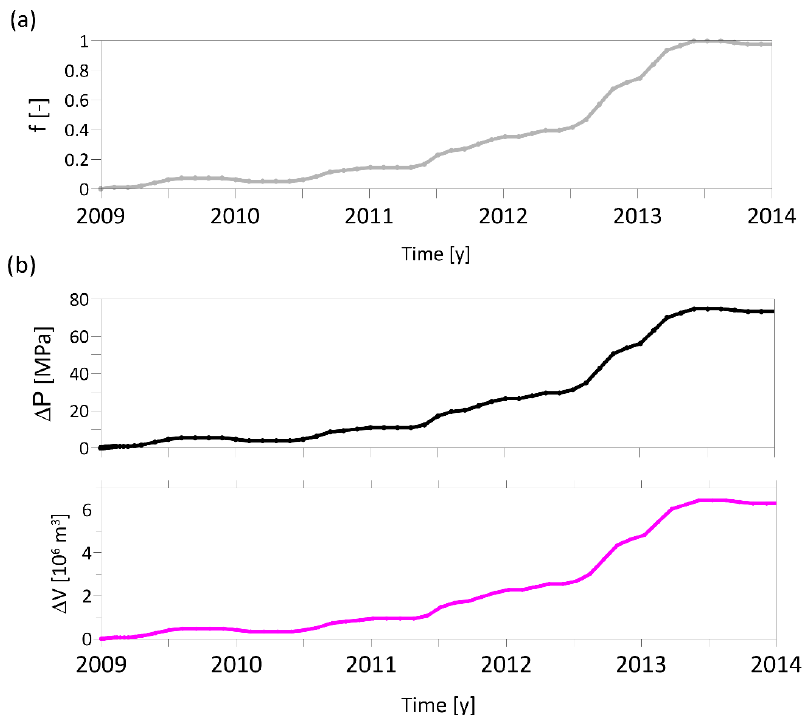
Figure 7. Time-dependent FE model results. ( a ) Modulating time function used for the FE time- dependent study ( f[-] refers to adimensional quantities ) . ( b ) Source Δ P (top panel) and Δ V (bottom panel) time series.